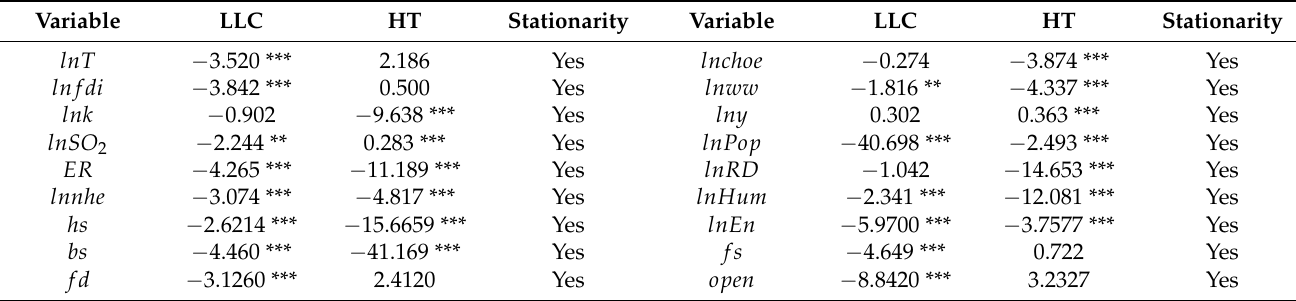
Table 2. Results of the panel unit root test.